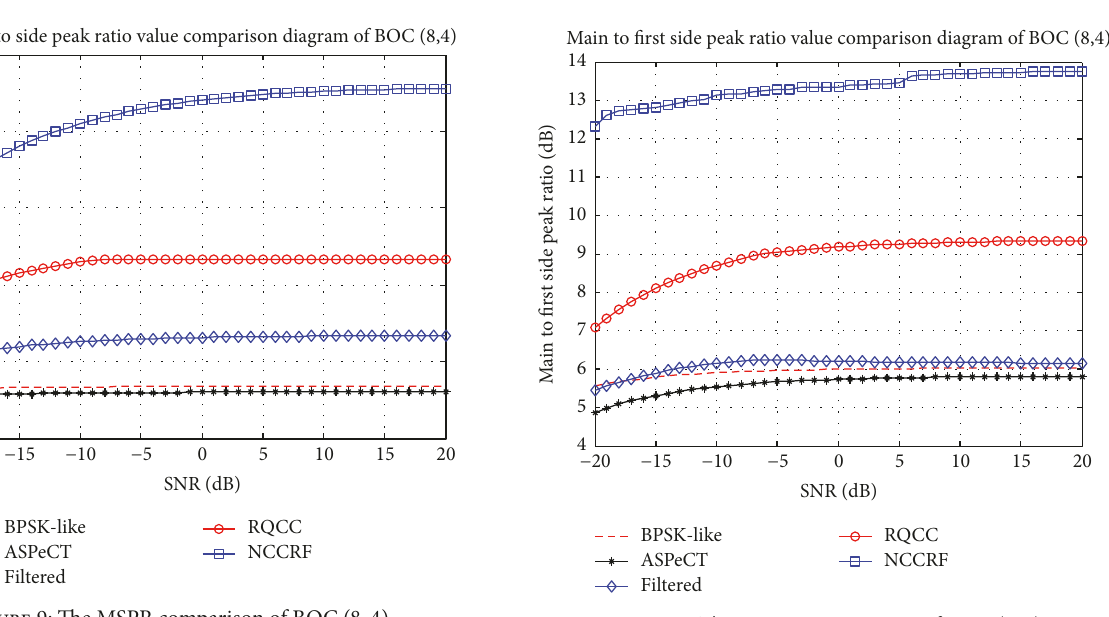
Figure 11: The MFSPR comparison of BOC ( 8,4 ). Main to first side peak ratio value comparison diagram of BOC (6,1)